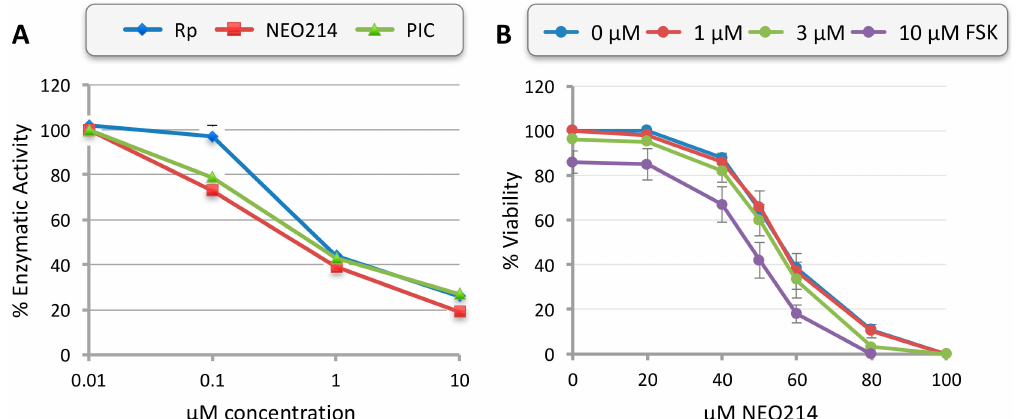
Figure 4. In vitro PDE4 activity and combination with forskolin. ( A ) The enzymatic activity of purified, recombinant PDE4A1A was determined in the presence of increasing concentrations of rolipram (Rp), NEO214, or piclamilast (PIC). Data shown are averages from two independent repeats, each one performed in duplicate. ( B ) RPMI/8226 cells were treated with combinations of NEO214 and forskolin (FSK). After 48 h, cell viability was determined by MTT assay. Survival of vehicle-only treated cells was set at 100%. Data points are mean ± SE from two experiments with each data point in